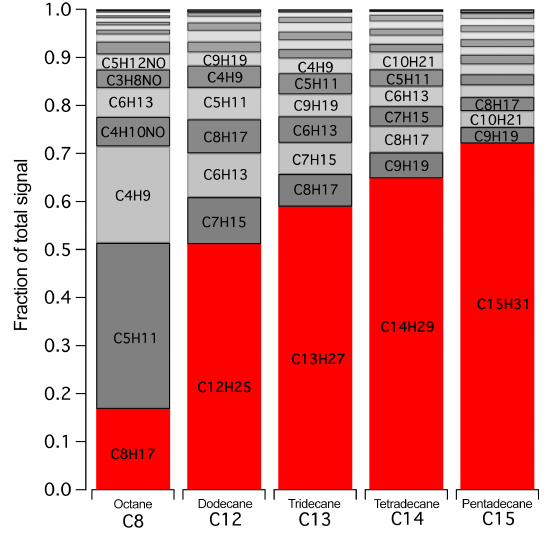
Figure 6. Large (C 12 –C 15 ) n-alkane product ion distribution, using relative humidity of 20%. The expected largest mass resulting from hydride abstraction ( m − 1) is highlighted in red. N-octane (C 8 ) is shown for